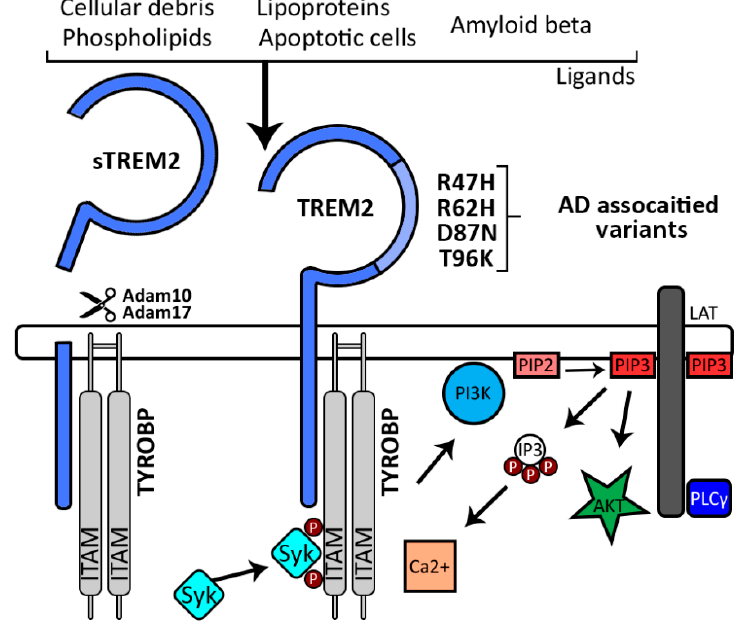
Figure 2. TREM2 activation and downstream signaling. sTREM2 is generated by ADAM10 or ADAM17 mediated proteolytic cleavage. Ligand-activated TREM2 interacts with immune receptor tyrosine-based activation motifs (ITAMs) on TYROBP, which leads to TYROBP phosphorylation and recruitment of spleen tyrosine kinase (SYK). TYROBP/SYK mediated activation of phosphoinositide 3-kinase (PI3K)—AKT pathway and phosphorylation of LAT (linker for activation of T-cells family member 1), recruits other signaling adaptors including phospholipase C γ (PLC γ ). PLC γ degrades phosphatidylinositol-3,4,5-trisphosphate (PIP3) into inositol trisphosphate (IP3), inducing an efflux of Ca 2+ . The ability of TREM2 to bind ligands is influenced by genetic variations, some of which are associated with AD, and located adjacent to or within an electrostatically basic patch (light blue).